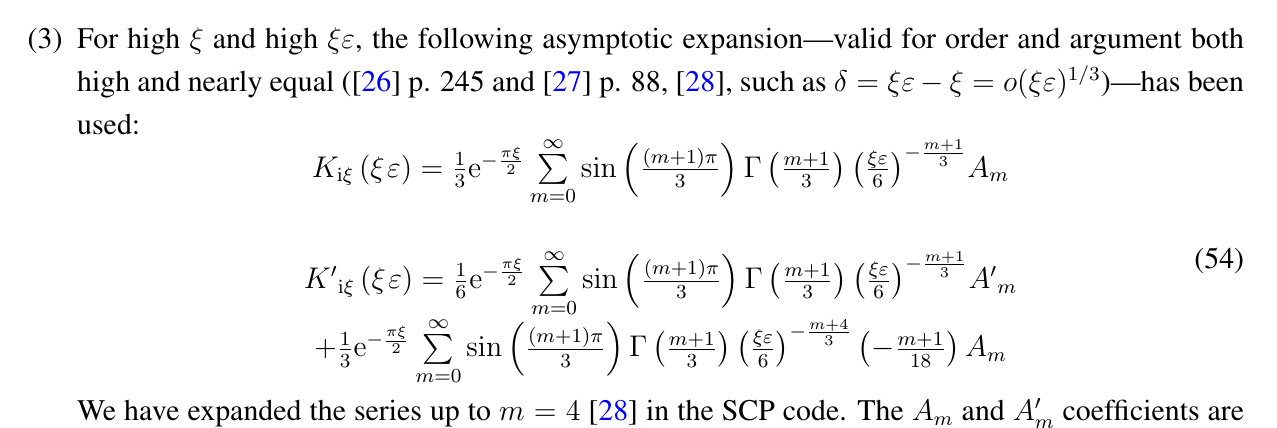
Table 2. Values of the coefficients A